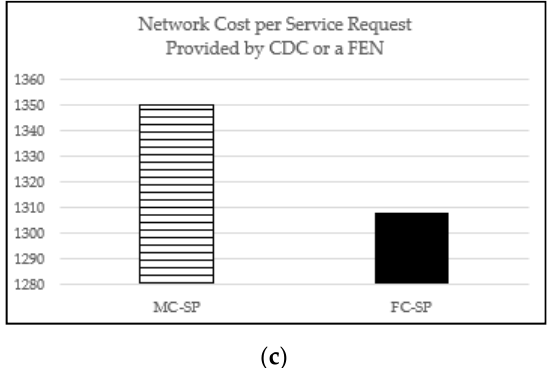
Figure 13. The performance with the maximum CDC capacity of 500 and 1000 service types for the U distribution case: ( a ) the number of service images placed; ( b ) the number of non-accommodated service requests; and ( c ) the network cost per service request provided by CDC or a FEN.